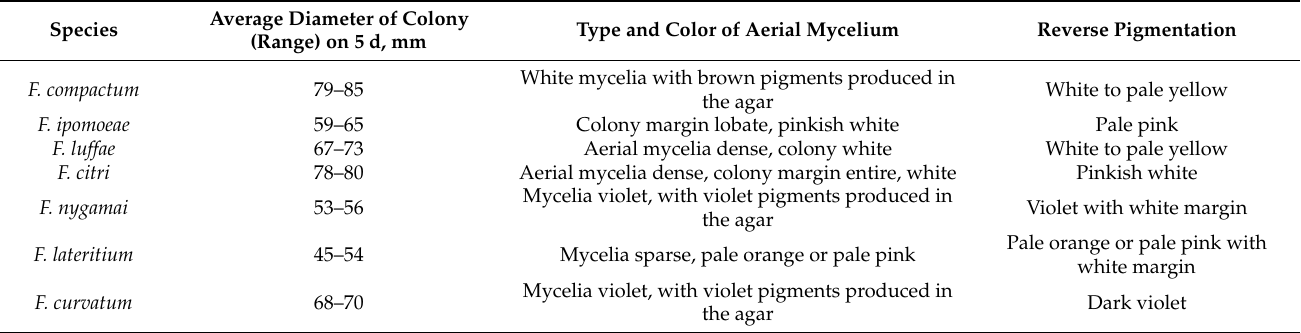
Table 2. Characteristics of colonies of Fusarium fungi cultivated on PDA.